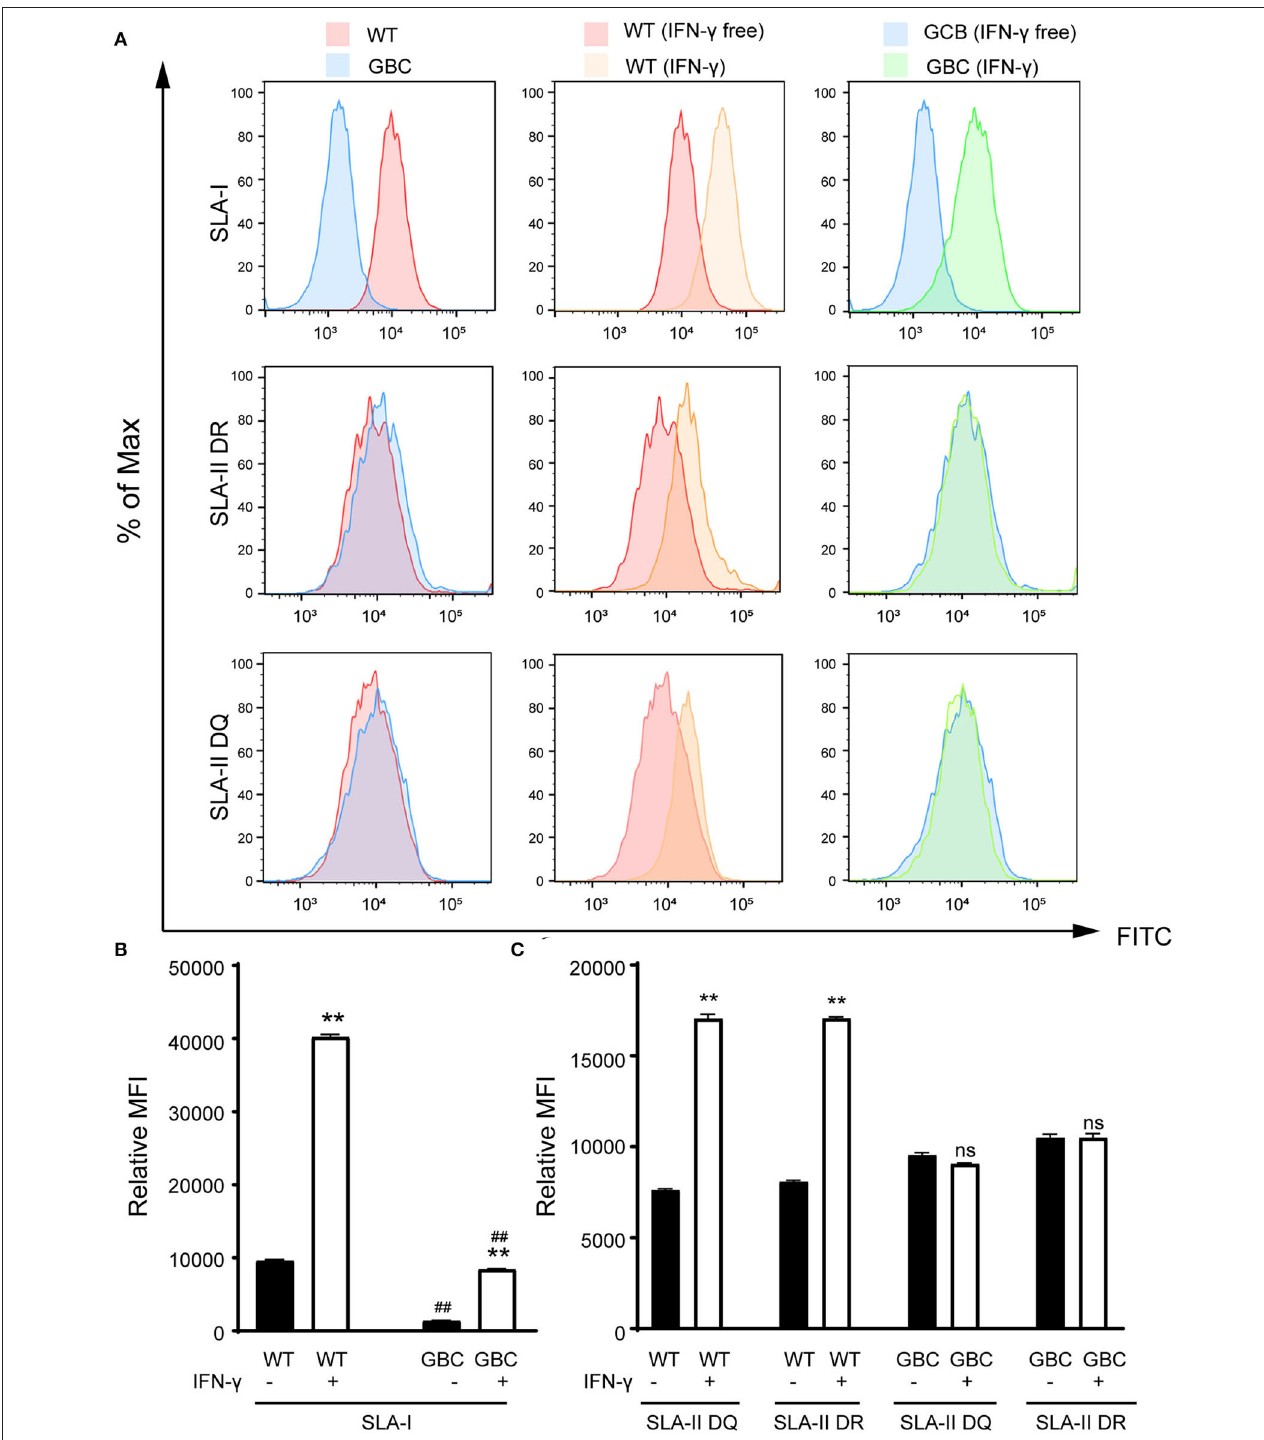
FIGURE 5 | Flow cytometry analysis of expression of SLA-I, SLA-II DR, and SLA-II DQ molecules in the umbilical vein endothelial cells (UVECs) of GBC-modified pigs. (A) The expression of the SLA-I molecule is lower in GBC-modified pigs than WT pigs. Additionally, interferon- γ treatment caused an increase in the number of SLA-I molecules in both GBC-modified and WT pig UVECs, but WT had a higher increase than the other. The expression of SLA-II DR and DQ molecules was comparable between GBC-modified and WT pig UVECs. After interferon- γ treatment, the expression of SLA-II DR and DQ molecules was increased in WT pig UVECs but not changed in GBC-modified pig UVECs. (B,C) Relative mean immunofluorescence intensity (MFI) of SLA-I (B) , SLA-II DR, and SLA-II DQ (C) in WT and GBC-modified pig UVECs treated with or without IFN- γ . Data of three dependent experiments are presented. ** P < 0.01 vs. IFN- γ -free; ## P < 0.01 vs. WT.